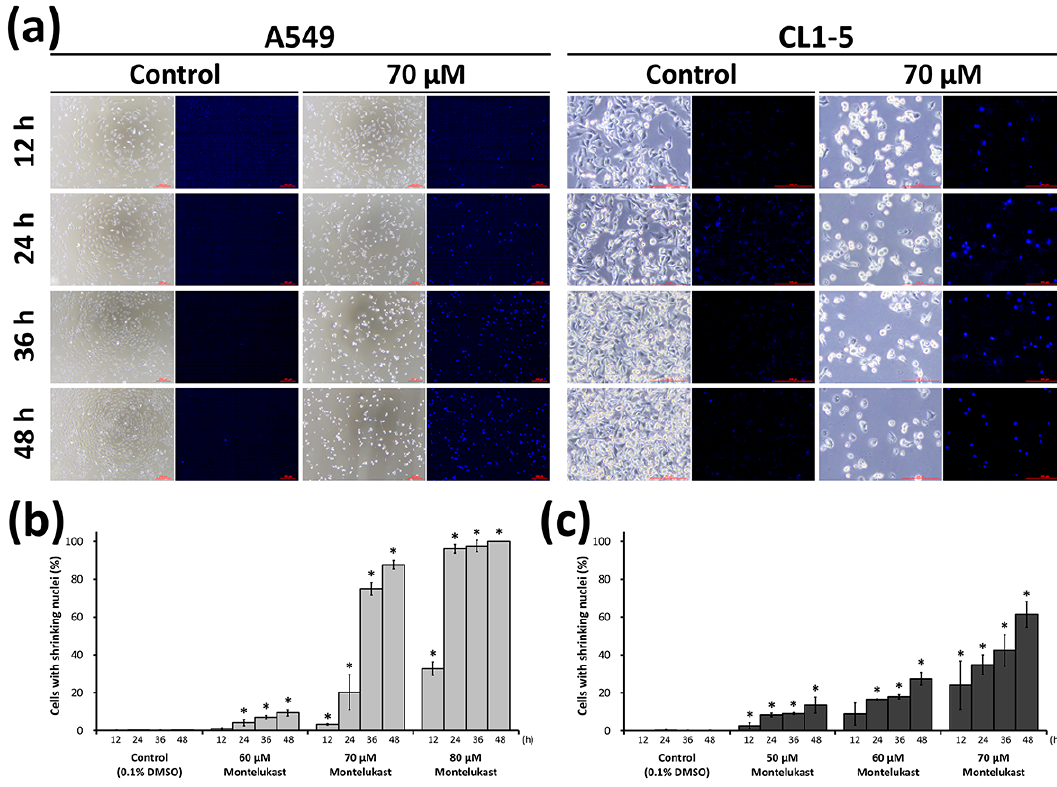
Figure 2. Montelukast-induced cell death of lung cancer cells. After being treated with various concentrations of montelukast for the indicated time (12, 24, 36, or 48 h), the cells (A549 and CL1-5) were observed with light microscopy and fluorescence microscopy (4’,6-diamidino-2-phenylindole (DAPI) staining). ( a ) Representative photographs of the cells were shown (The detailed photographs are presented in Figure S1); ( b , c ) The percentages of A549 ( b ) and CL1-5 ( c ) cells with shrinking nuclei were calculated. All results were expressed as the mean ± SD of three independent experiments performed on different days. * p < 0.05, as compared with the corresponding control (0 µ M) group.